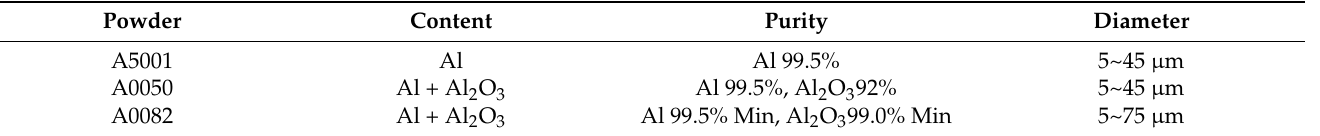
Table 1. Parameters and details of